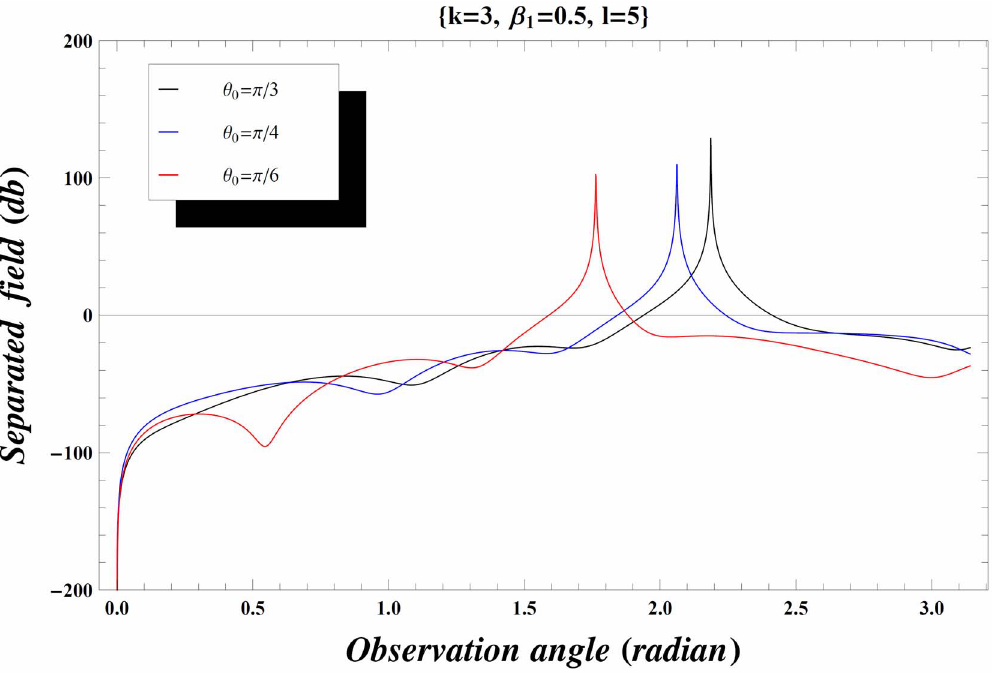
Figure 4. Separated field versus observation angle for different values of incidence angle h 0 when k ~ 3 .